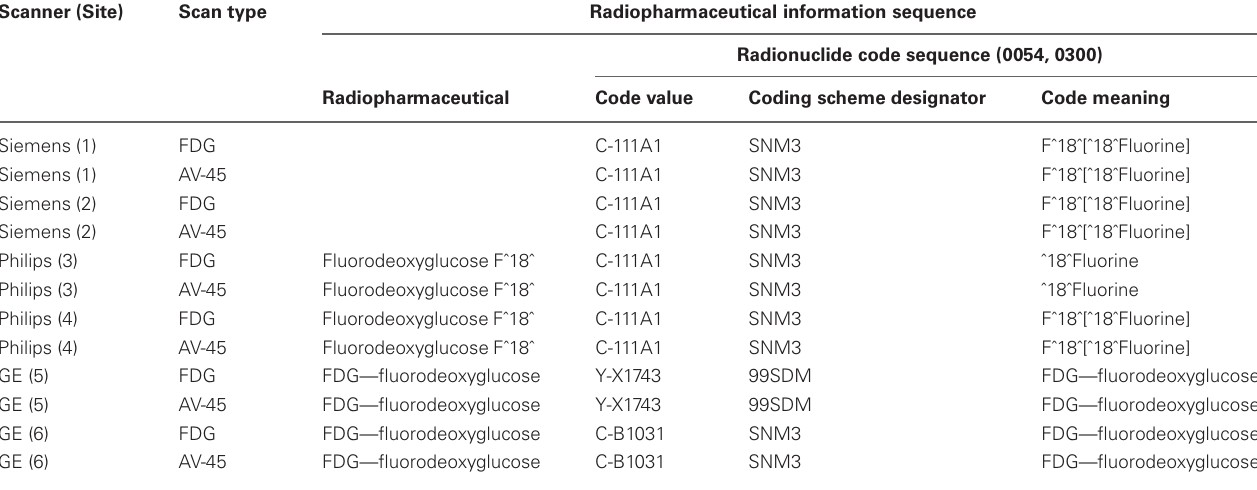
Table 3 | Comparison of coding and terms utilized across scanners and sites producing DICOM files. Scanner